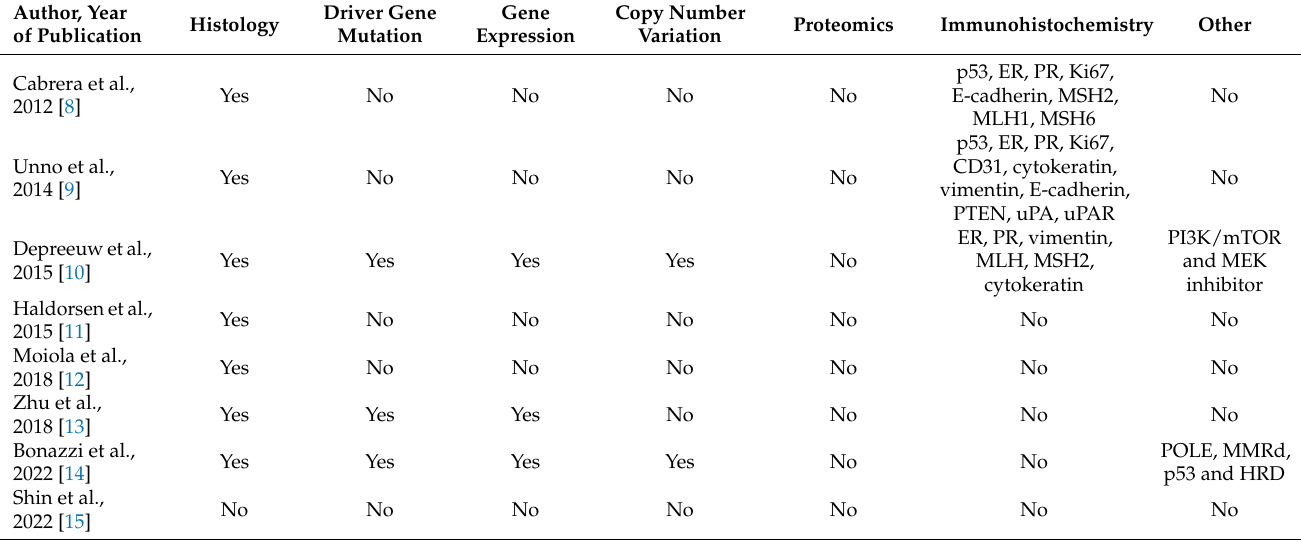
Table 3. Validation methods and parameters used to demonstrate that PDXs resemble their donor patient tumors in the eight studies that explored PDX